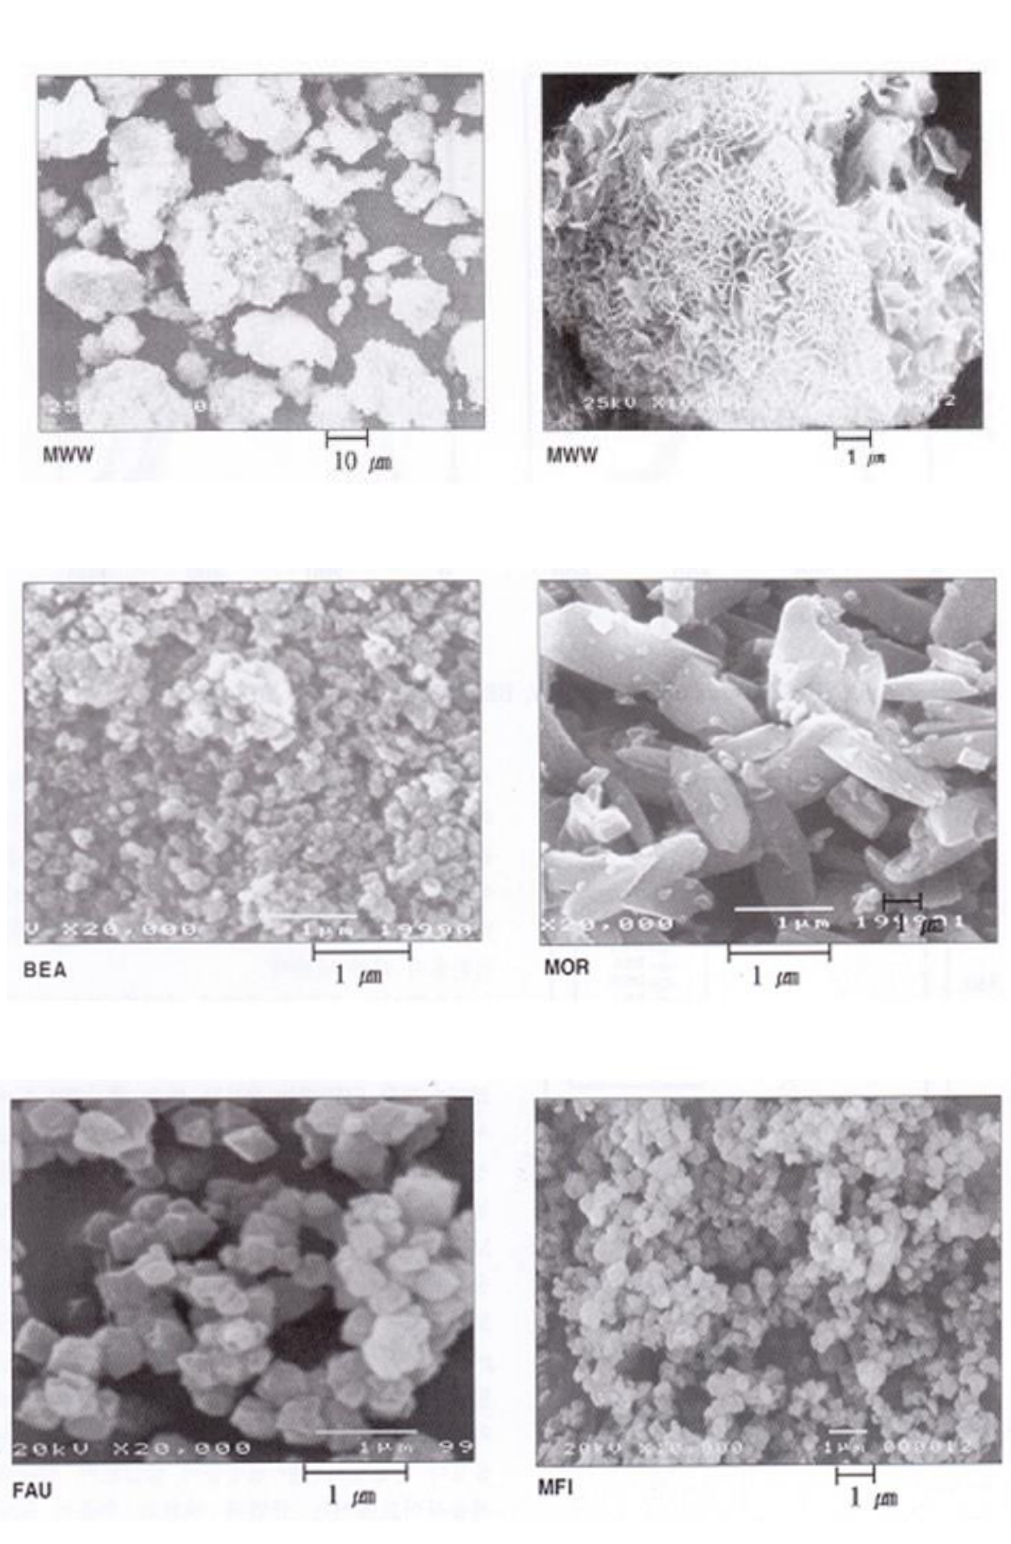
Figure 2. SEM images of the MWW, BEA, MOR, FAU, and MFI